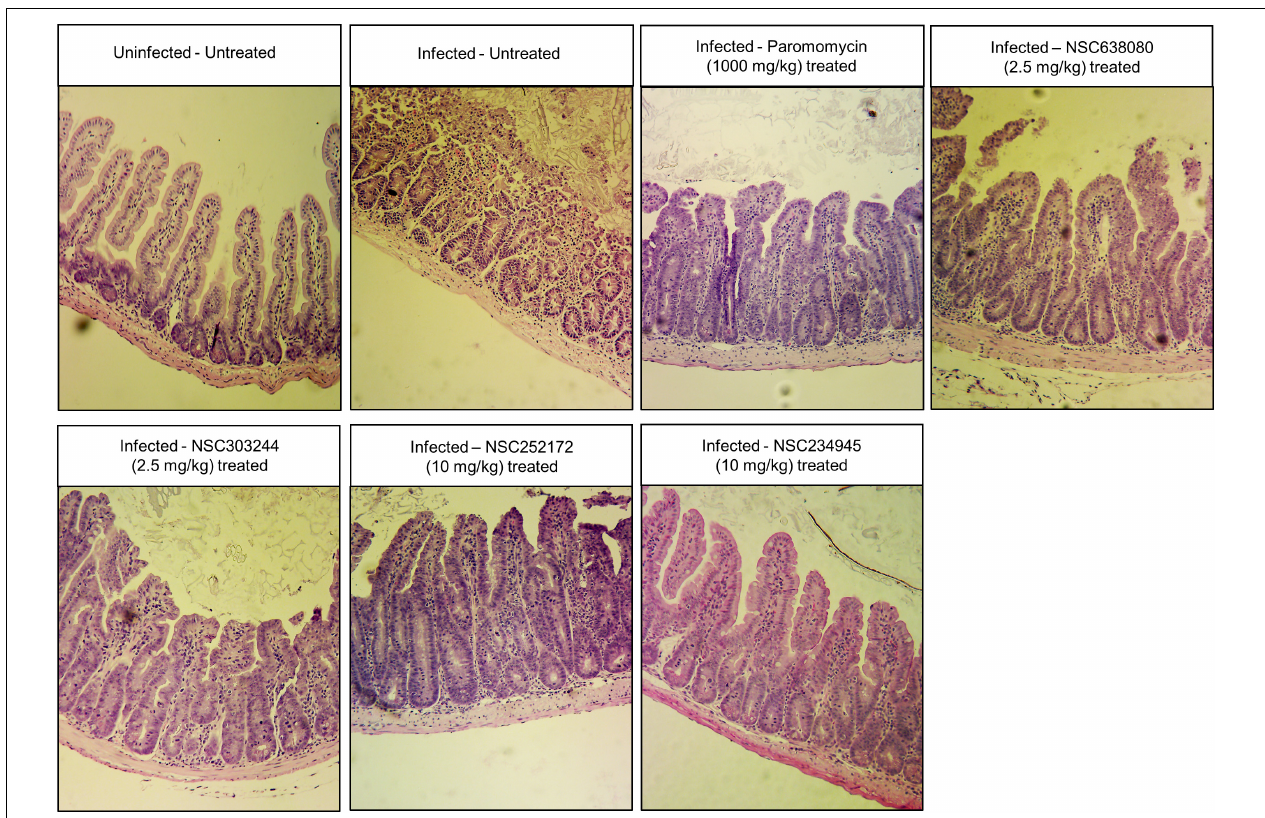
FIGURE 7 | Histological analysis of the distal small intestines of mice infected with Cryptosporidium parvum with or without treatment. Male IFN- γ KO mice ( n = 3 per group) were infected with 10 4 C. parvum oocysts, and from the third day post-infection, daily oral treatment was commenced with NSC638080 (2.5 mg/kg), NSC303244 (2.5 mg/kg), NSC252172 (10 mg/kg), NSC234945 (10 mg/kg), or paromomycin (1,000 mg/kg). The untreated-uninfected control group of mice was administered an equivalent volume of the solvent used to reconstitute the test compounds (5% DMSO in water). After day 11 post-infection, mice were sacrificed, and the distal small intestinal tissue processed for histology and stained with hematoxylin and eosin. The uninfected-untreated control mice’s samples depicted intact intestinal epithelium with prominent villi. The infected–untreated mice depicted denuded villi, infiltration of inflammatory cells and hypertrophy of crypts. In contrast, samples from infected mice treated with the test compounds or paromomycin had notably reduced pathological changes (intact intestinal epithelium with prominent villi), especially treatment with compounds NSC252172 and NSC234945. The images are representative of samples analyzed from three mice per treatment